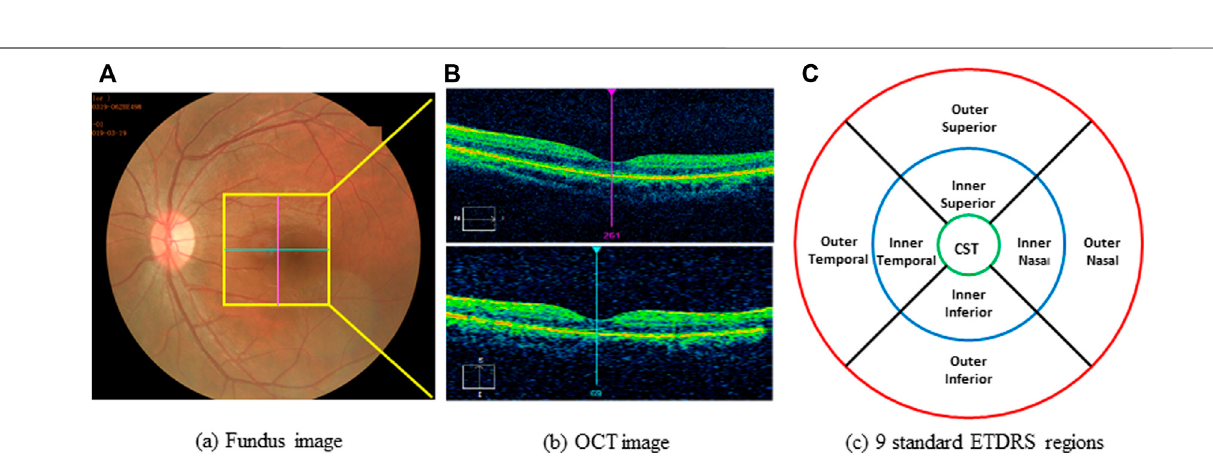
Frontiers in Physiology |